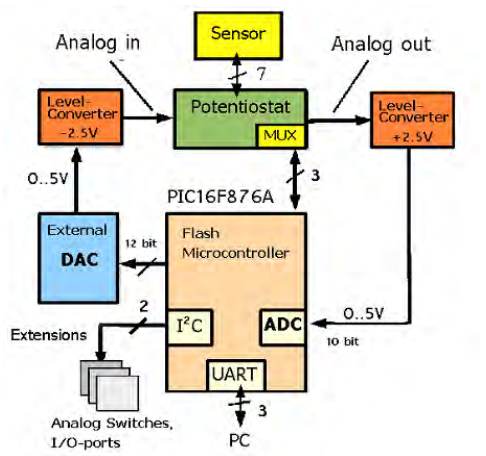
Figure 2. The MATLAB user interface that is used to carry out the voltammetry techniques for the electronic tongue sensor operations.